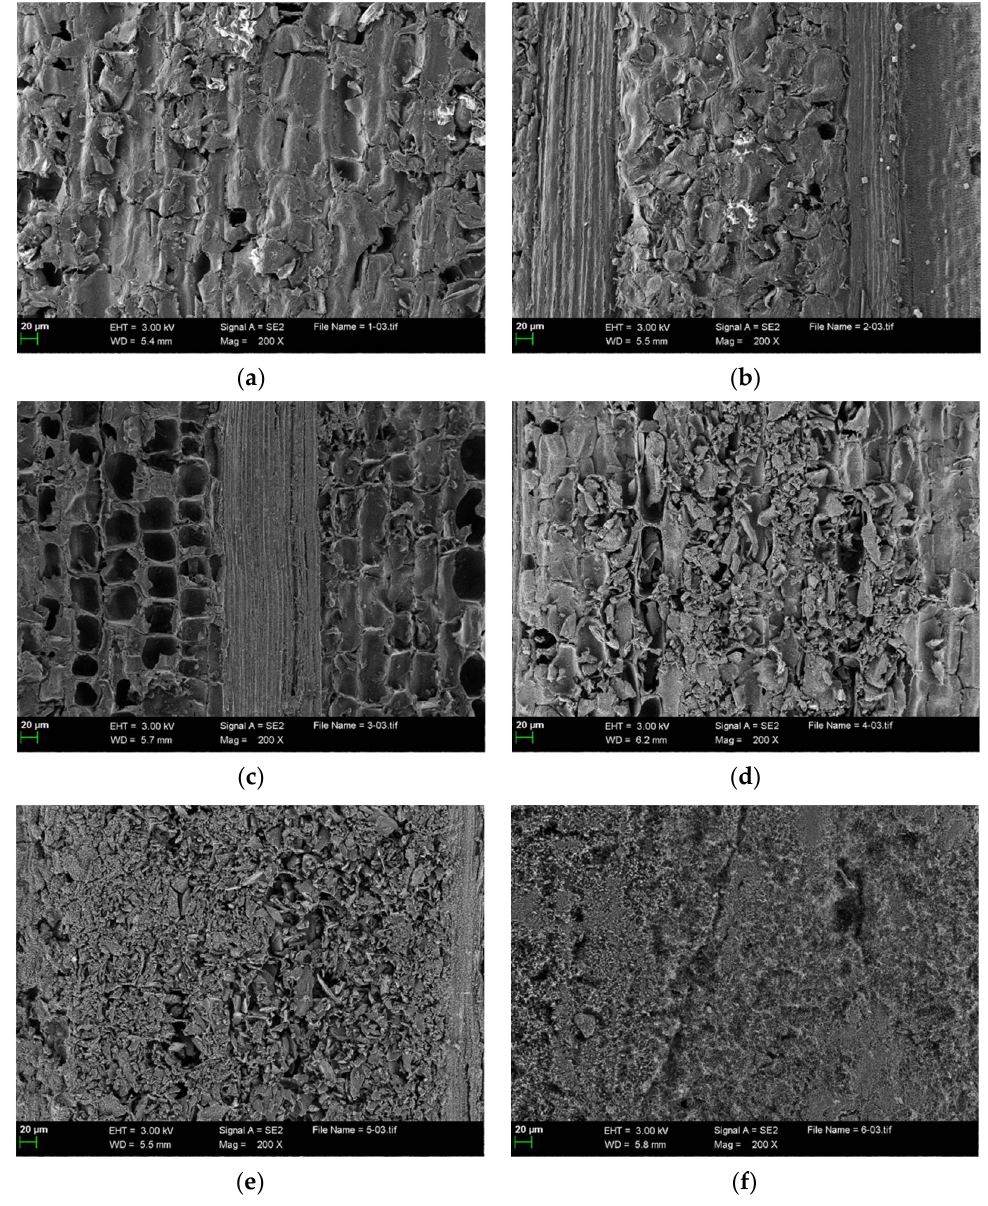
Figure 3. SEM images of produced biochars. ( a ) BCBC-400-2; ( b ) BCBC-400-4; ( c ) BCBC-500-2; ( d ) BCBC-500-4; ( e ) BCBC-600-2; ( f ) BCBC-600-4.